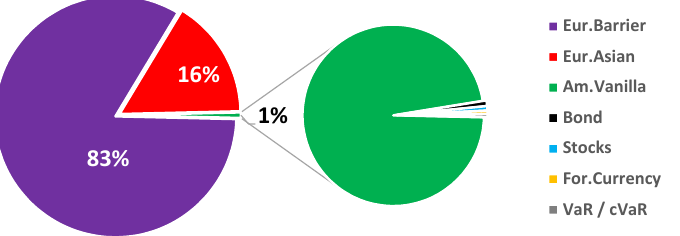
Figure 2. Runtime percentages of the complete value-at-risk (VaR)/conditional value-at-risk (cVaR) computation (Matlab testbench), following Table 1 and Section 3.1. Hardware: personal computer (PC) with MSI B85M-E45 motherboard [20], Intel Core I7-4970 [21], 16 GB DDR3 memory, running Windows 7 Professional